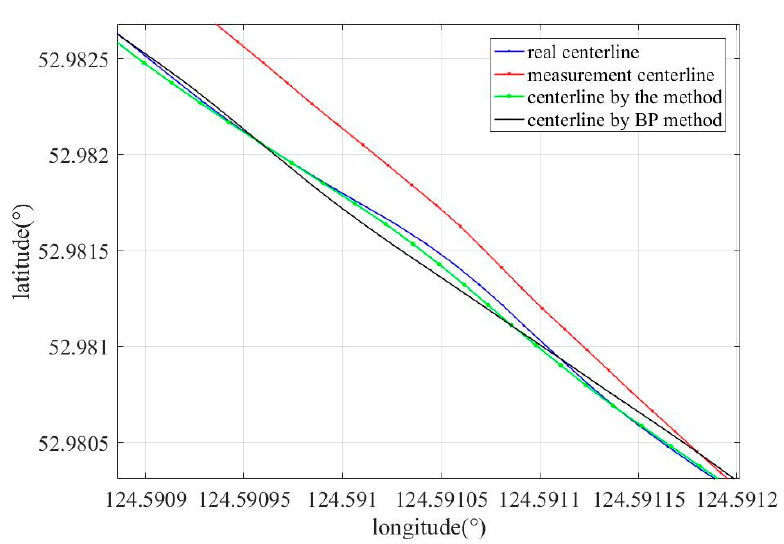
Figure 15. Zoom-in of centerline modified by different methods.